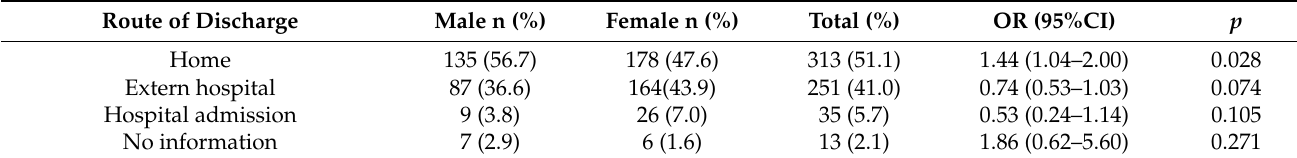
Table 7. Route of